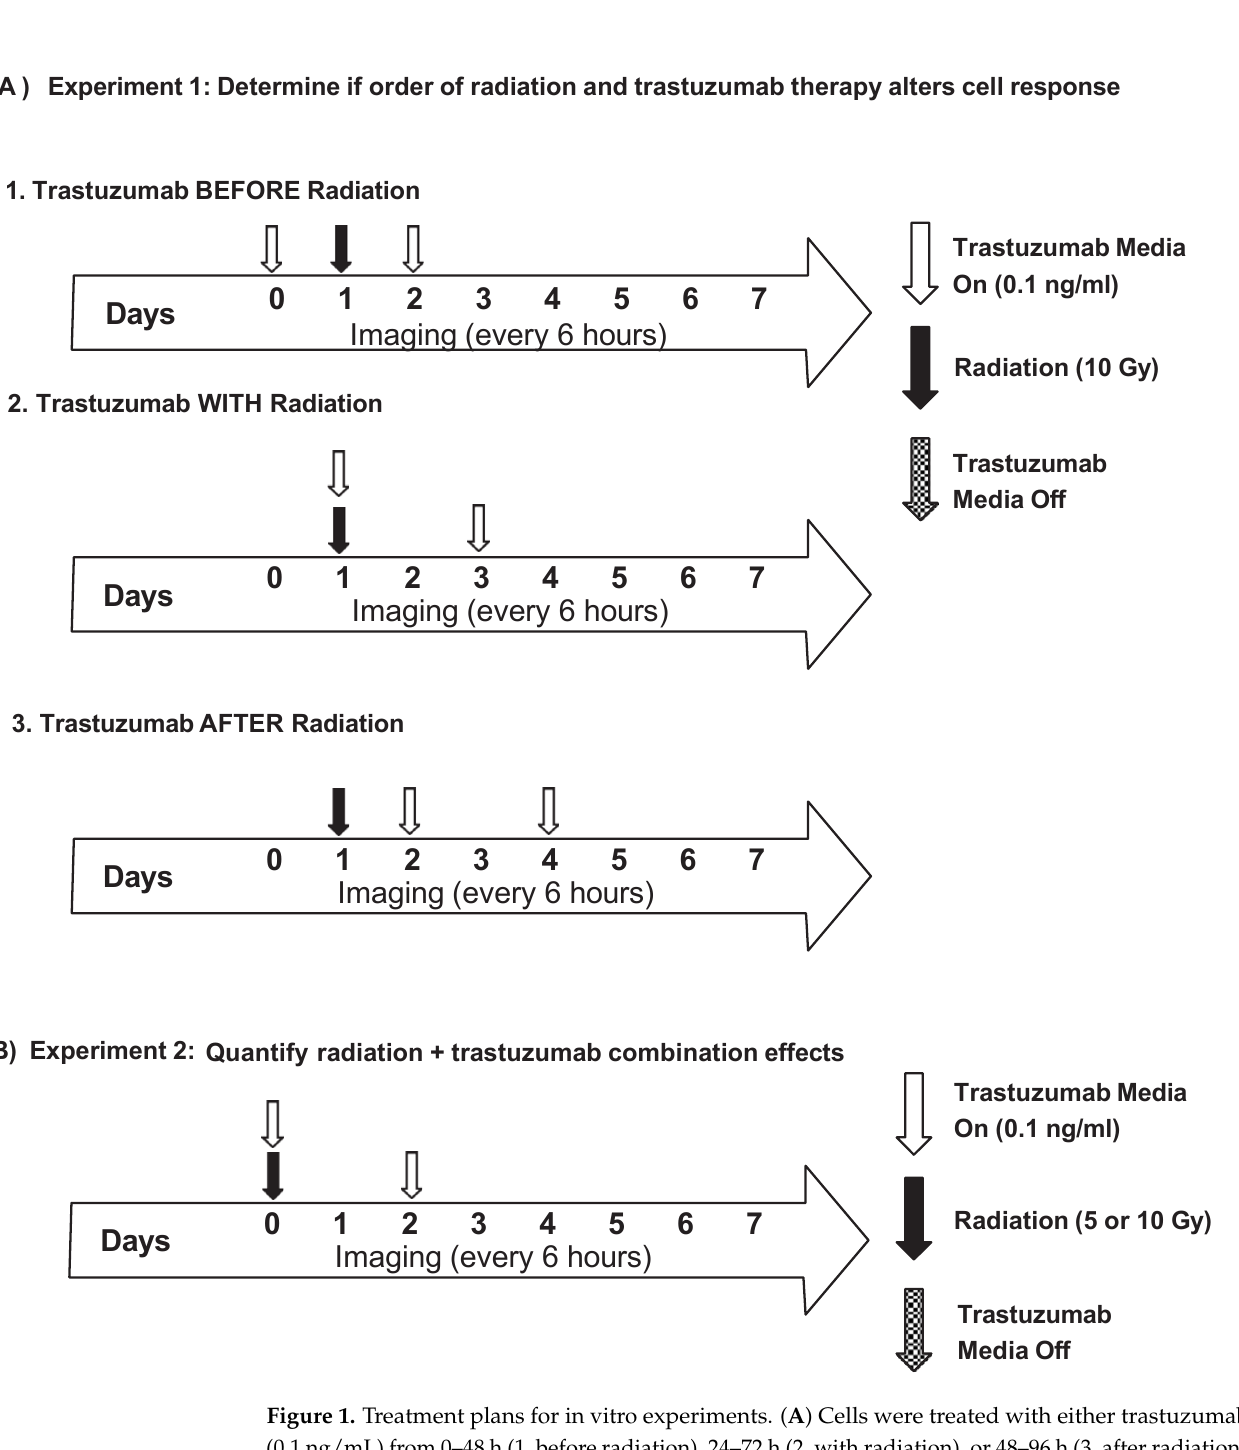
5000 cells/well. Twenty-four hours later (Day 0), the cells were treated with either 0.1% saline, trastuzumab (0.1 ng/mL), or radiation (5 or 10 Gy) for the control and single-agent treatment groups. Combination groups received both trastuzumab (0.1 ng/mL) and